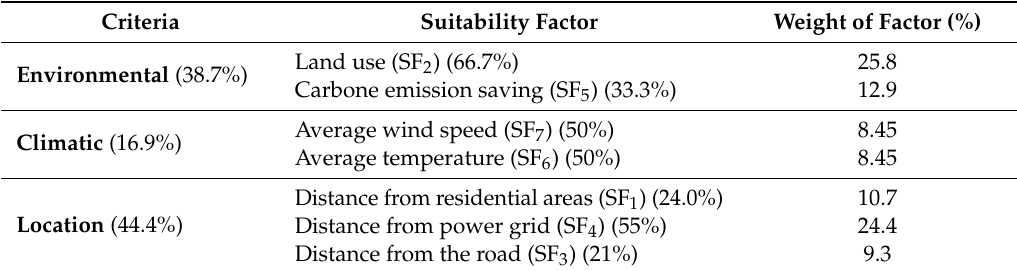
Table 11. Weight of criteria and factors.